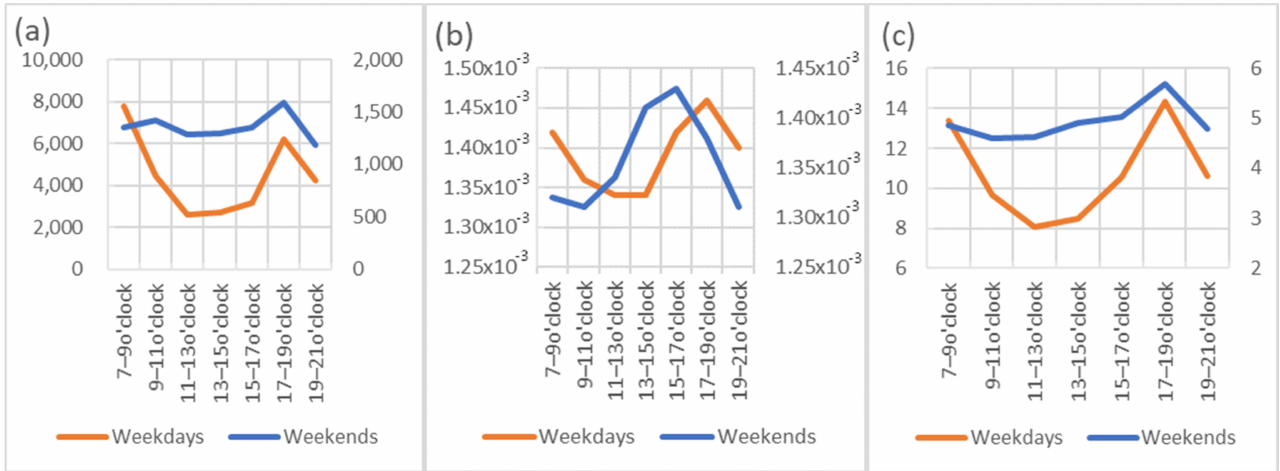
Figure 5. Temporal variations of the three weighted centrality indices on weekdays and weekends: ( a ) degree; ( b ) between- ness; ( c )